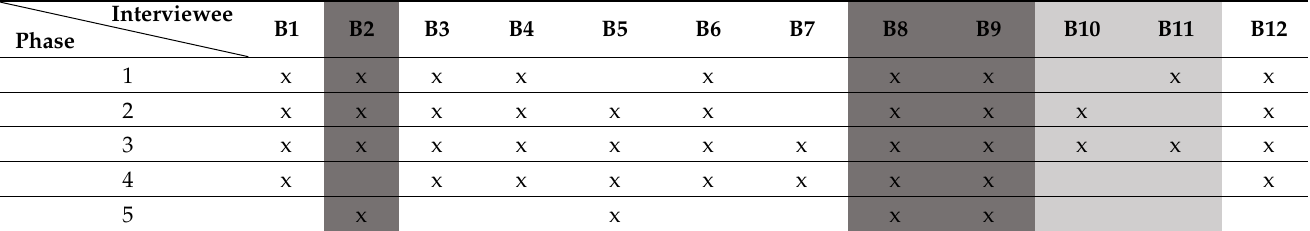
Table 3. Phases experienced by